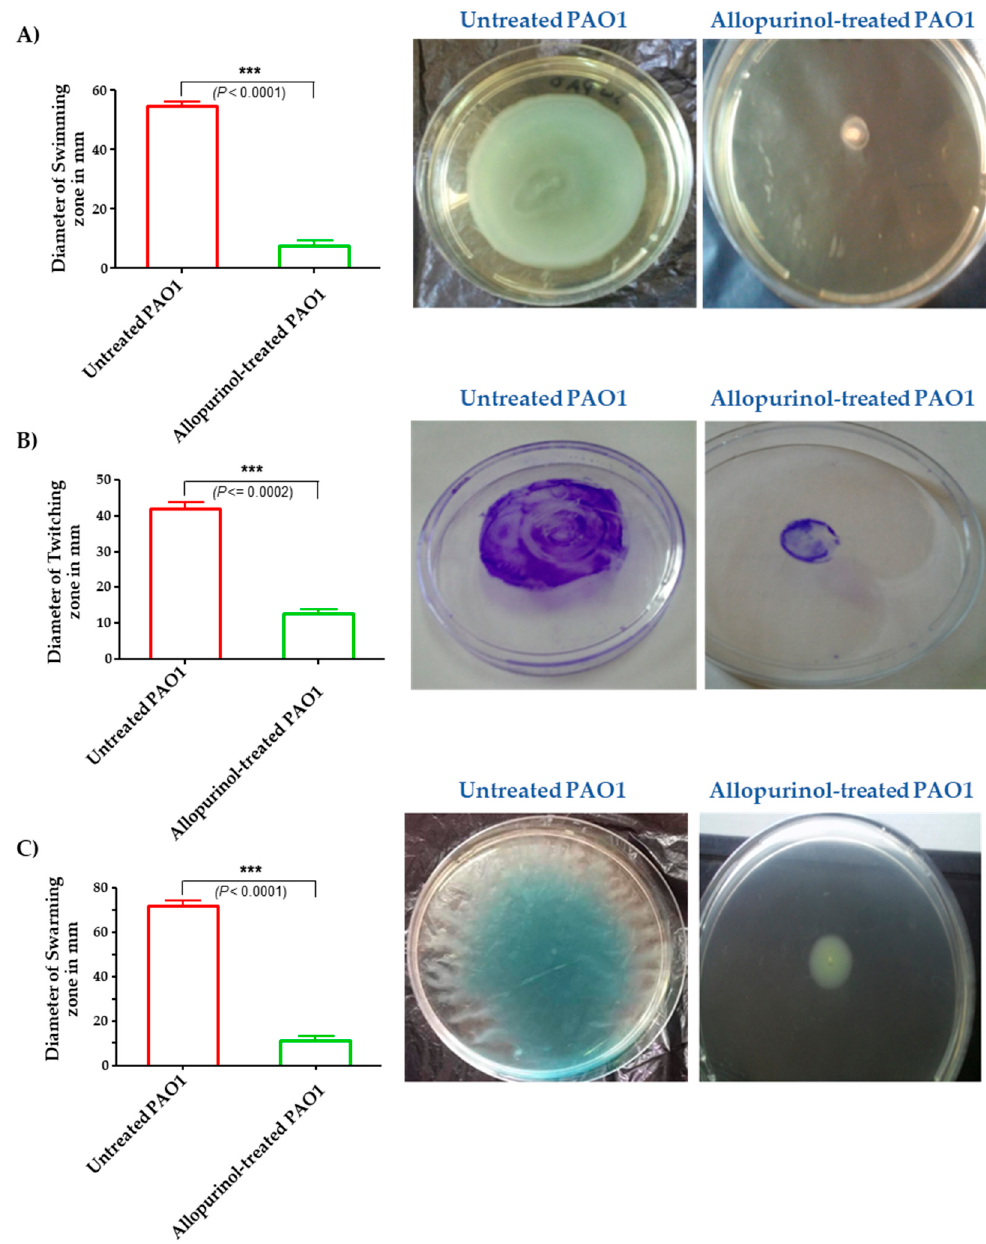
Figure 4. Diminishment of the ( A ) swimming, ( B ) twitching, and ( C ) swarming motilities of P. aeruginosa PAO1 by allopurinol. Significantly, the bacterial motilities were diminished by allopurinol at sub-MIC.